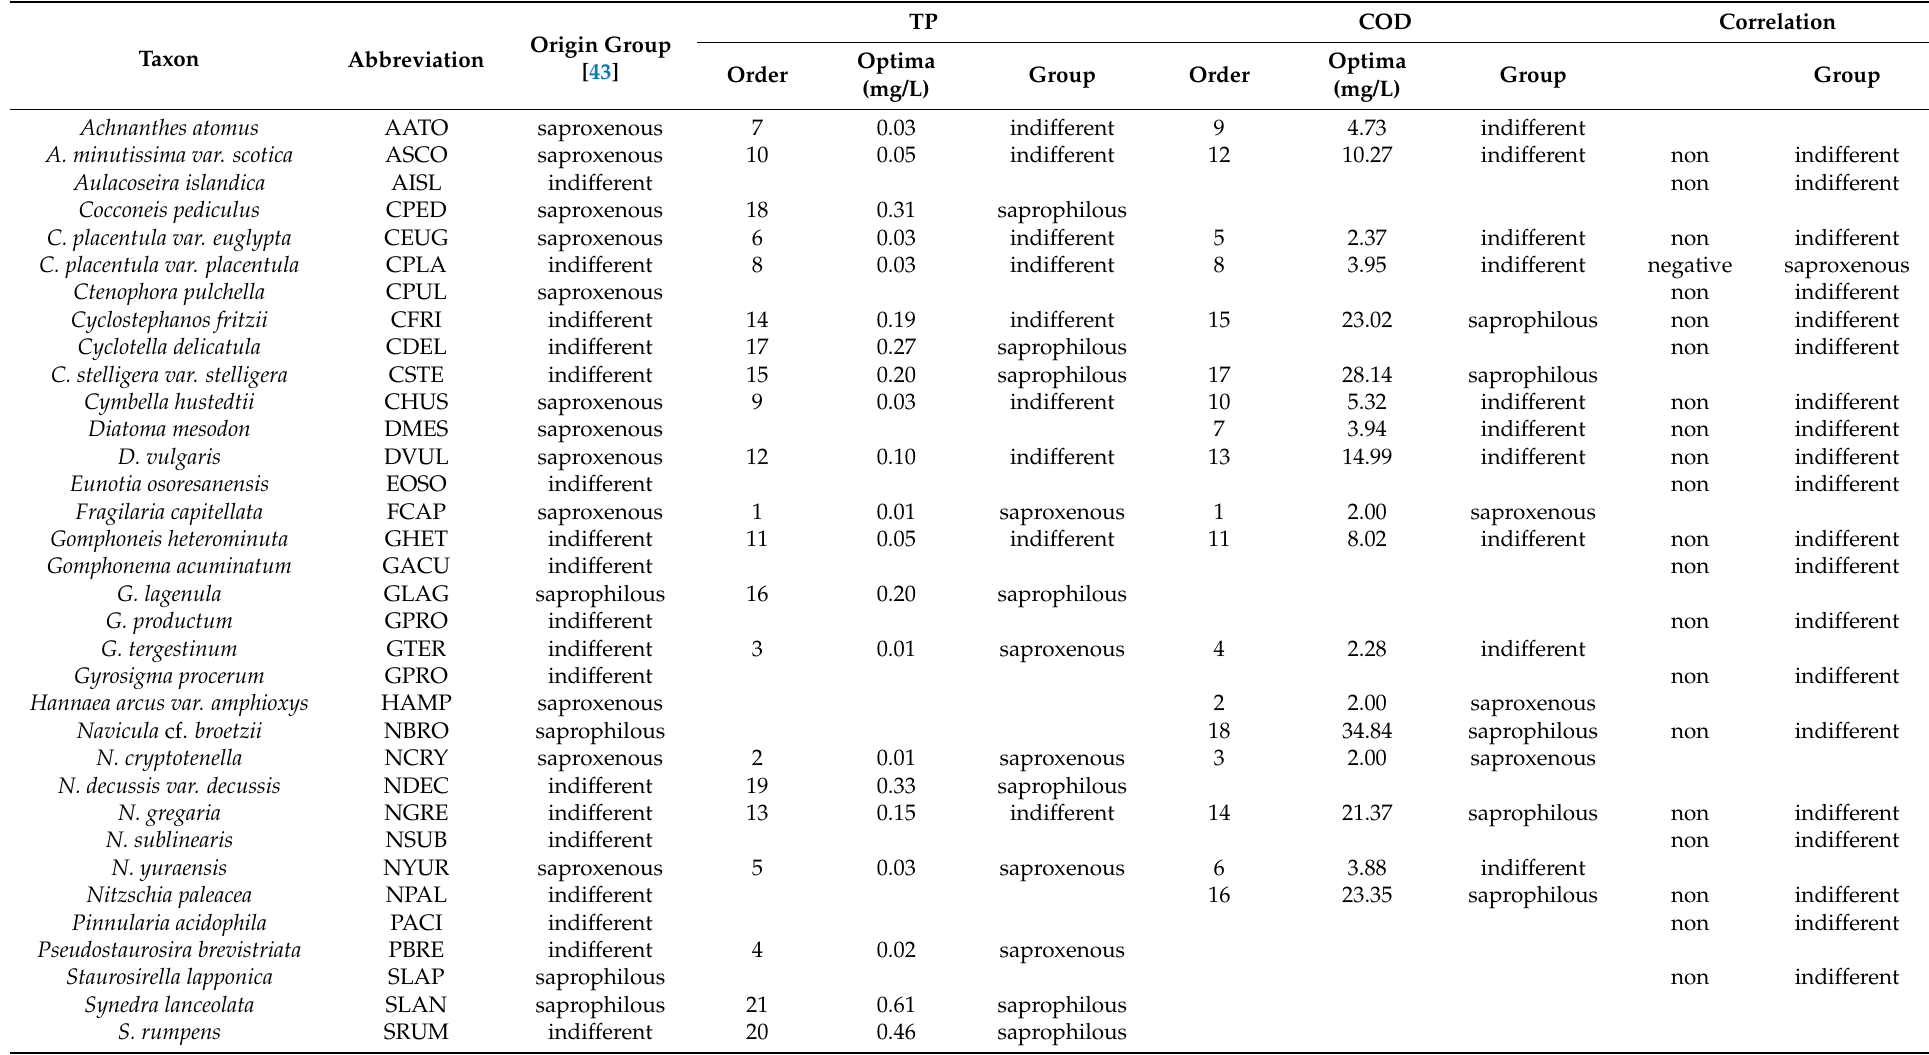
Table 2. Diatom TI value and taxa groups in the Yuqiao Reservoir